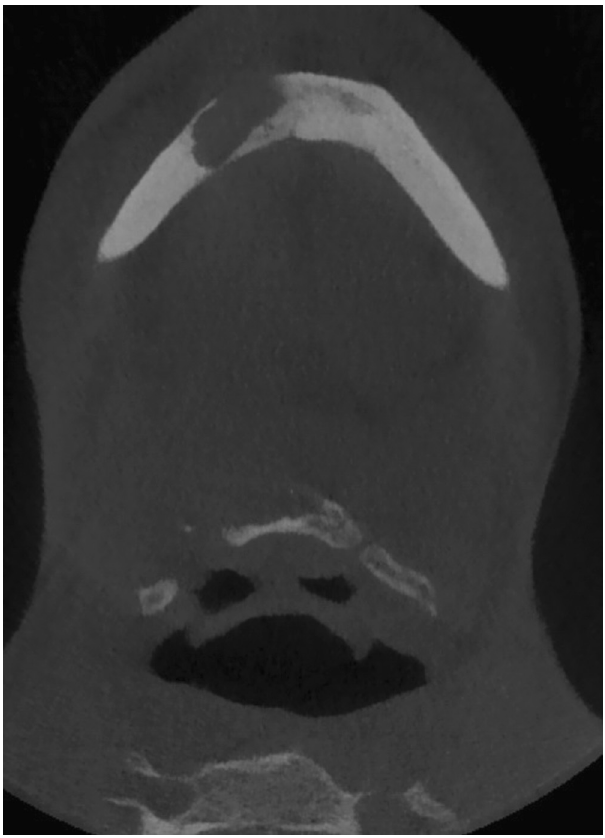
Fig. 5. Cone Beam Computed Tomography showing a recurrence on the mandibular symphysis 2 years and a half after the initial